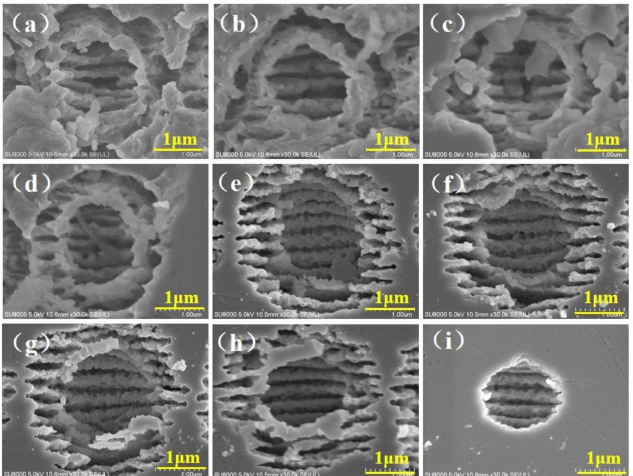
Figure 3. The surface morphology of microholes was ablated by Bessel beam with different single pulse energy and pulse numbers. ( a ) The microholes were ablated with Bessel Beam at 4 µ J, and pulse number were 1 × 10 6 ; ( b ) The microholes were ablated with Bessel Beam at 4 µ J, and pulse number were 1 × 10 5 ; ( c ) The microholes were ablated with Bessel Beam at 4 µ J, and pulse number were 1 × 10 4 ; ( d ) The microholes were ablated with Bessel Beam at 3 µ J, and pulse number were 1 × 10 6 ; ( e ) The microholes were ablated with Bessel Beam at 3 µ J, and pulse number were 1 × 10 5 ; ( f ) The microholes were ablated with Bessel Beam at 3 µ J, and pulse number were 1 × 10 4 ; ( g ) The microholes were ablated with Bessel Beam at 2 µ J, and pulse number were 1 × 10 6 ; ( h ) The microholes were ablated with Bessel Beam at 2 µ J, and pulse number were 1 × 10 5 ; ( i ) The microholes were ablated with Bessel Beam at 2 µ J, and pulse number were 1 × 10 4